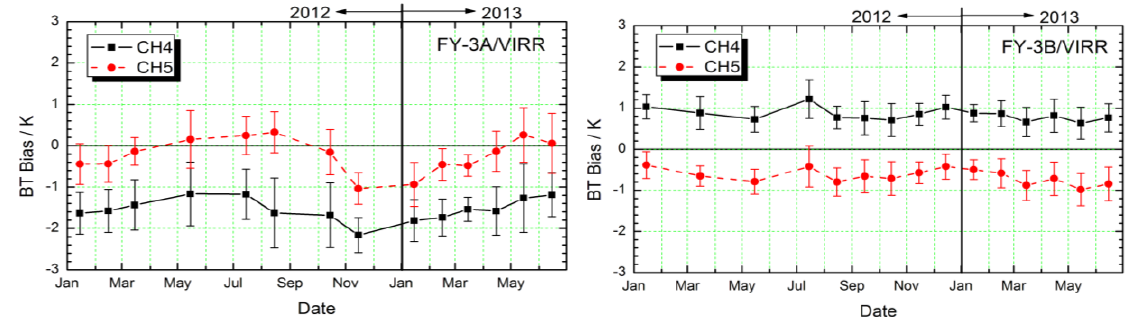
Figure 9. Seasonal variation of BT biases in channel 4 and 5 of FY-3A&3B VIRR versus IASI during January 2012 to June 2013, where the dot denotes mean bias, and the length of short bars indicate twice